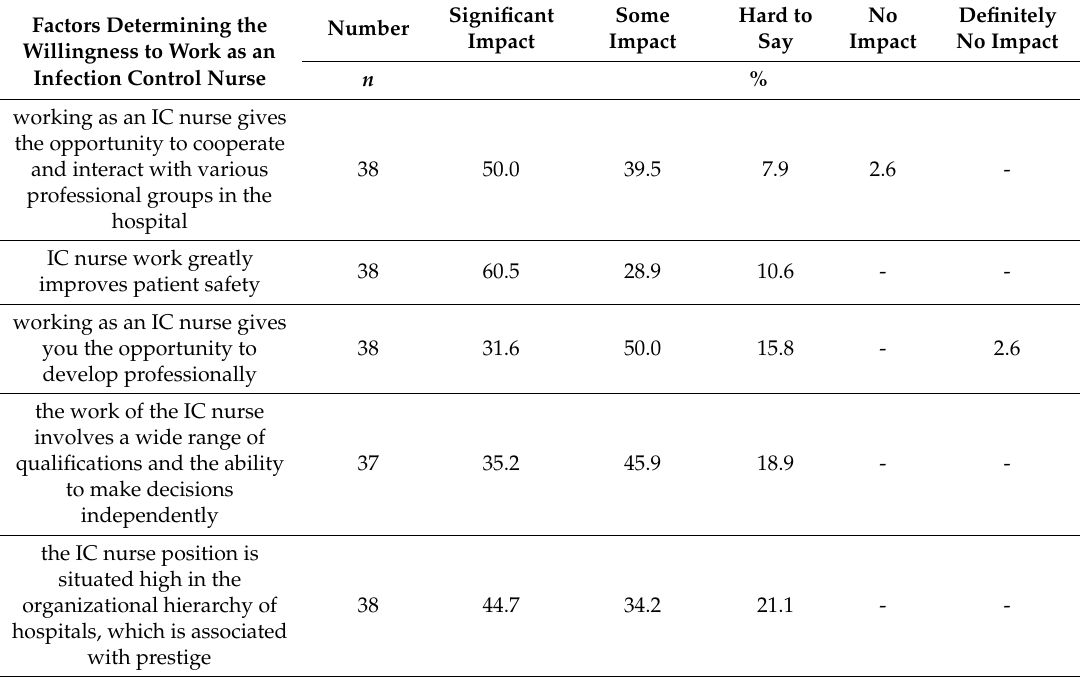
Table A1. Reasons for interest in working as an infection prevention and control